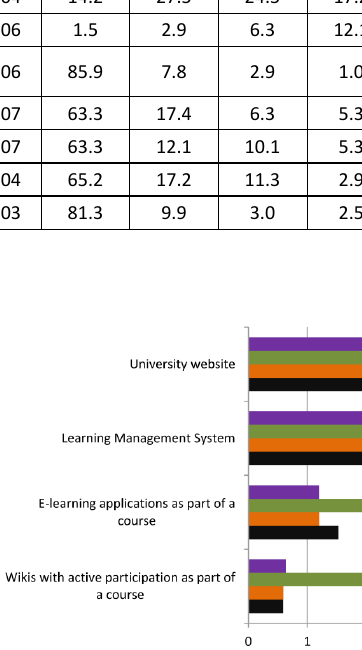
Figure 14. Students from four selected universities, one in Canada (valid n = 985), Germany (valid n = 1236), Spain (valid n = 981), and Thailand (valid n